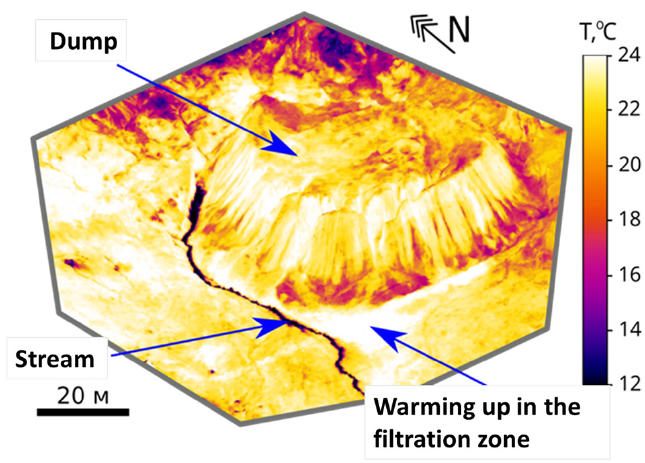
Figure 11. Digital model of the Ursk dump surface temperature.